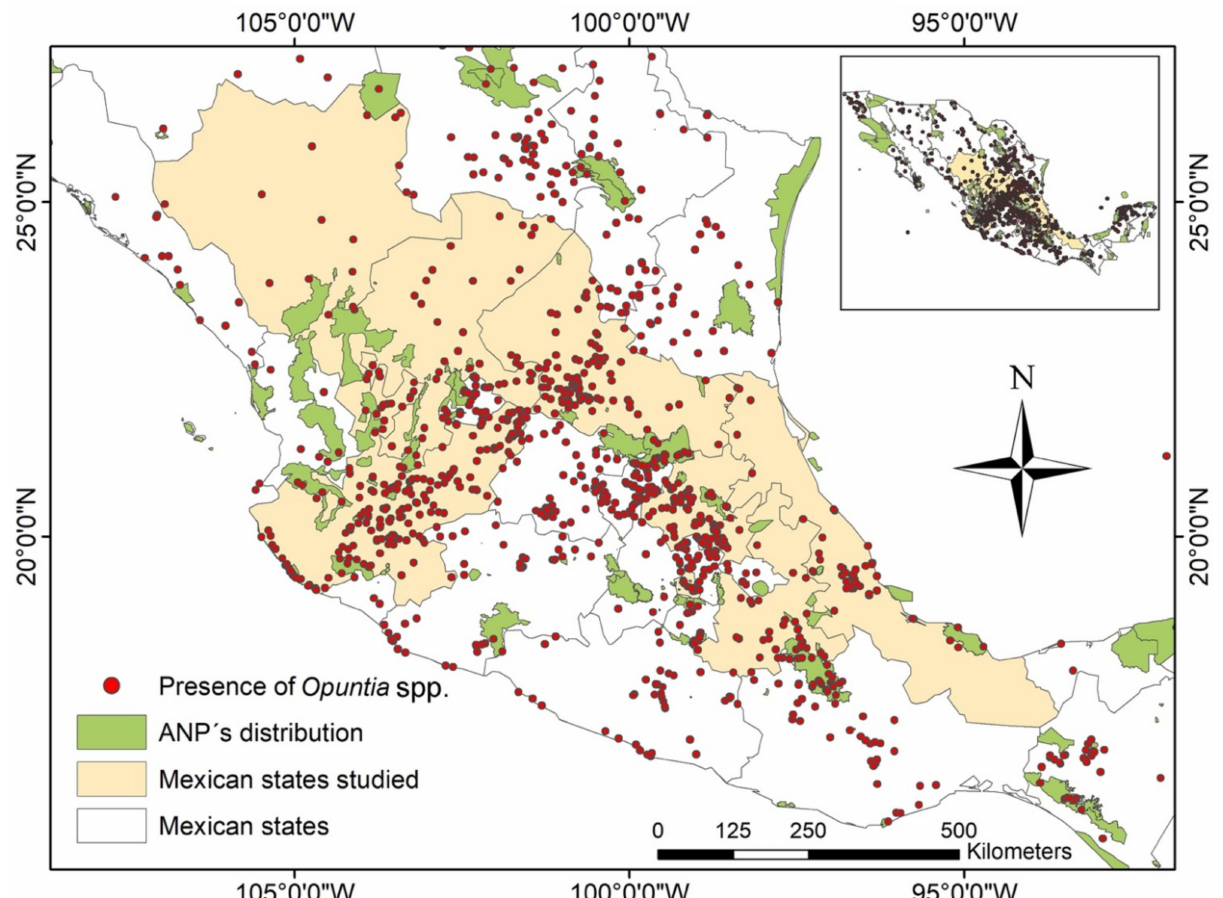
Figure 3. Distribution of Opuntia species throughout Mexico, highlighting the states where studies in articles retrieved were carried out, as extracted from the Global Biodiversity Information